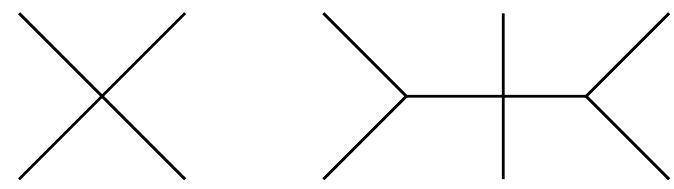
Figure 3. The left diagram consists only of a vertex. It has only on-shell states attached, so it is generated by BSFT. The right diagram has one vertex with two internal lines and two vertices with only a single internal line. Because BSFT does not contain the latter type of vertex, BSFT does not generate this